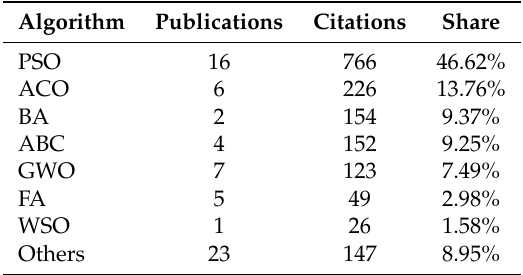
Table 4. Impact (share of citations) of SI algorithms for